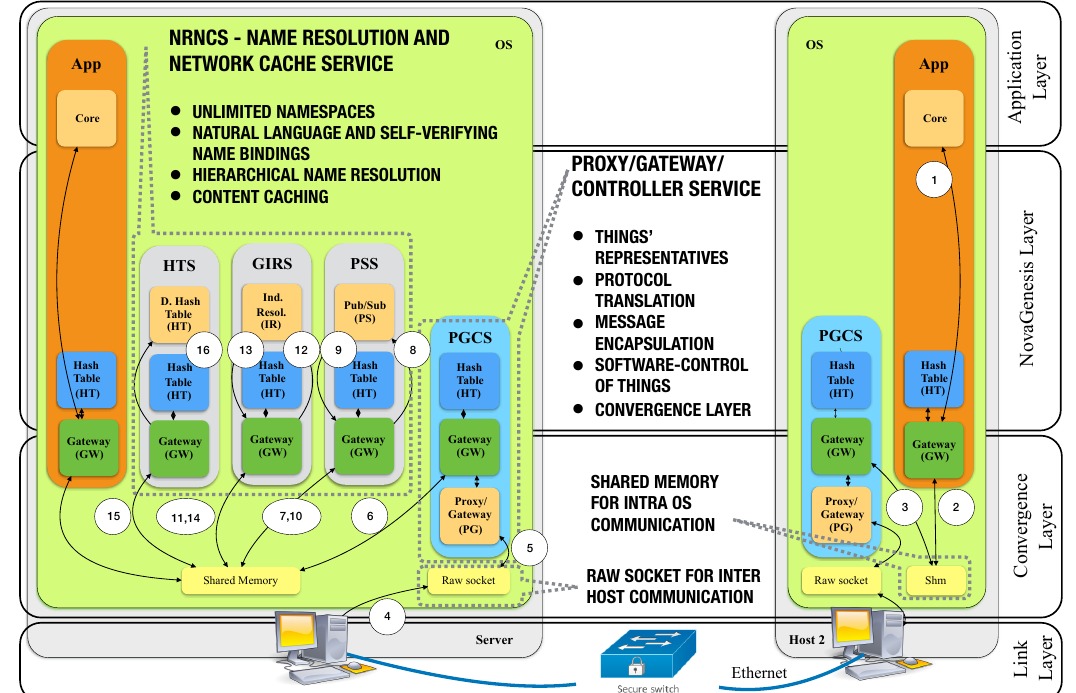
(HT)Core Figure 4. A layered model of the NovaGenesis architecture in a local domain. The convergence